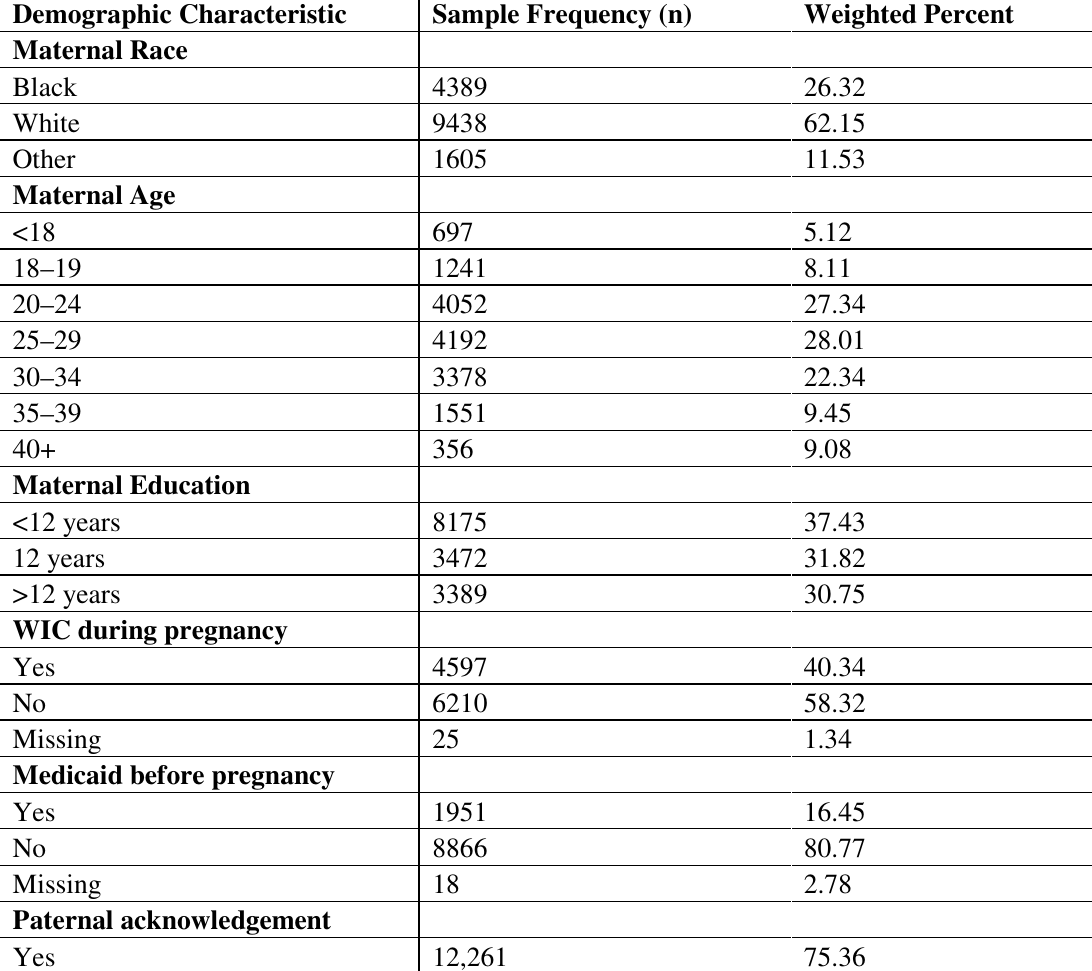
Table 1. Maternal demographic characteristics (all